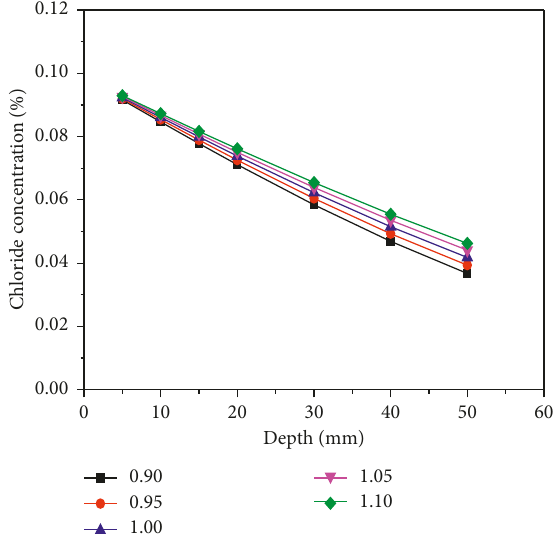
Figure 11: Chloride profile vs. stress state according to the proposed model (equations (14a) and